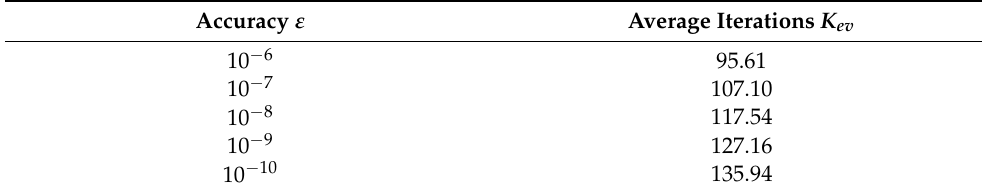
Table 4. Average iterations and time for different accuracy.